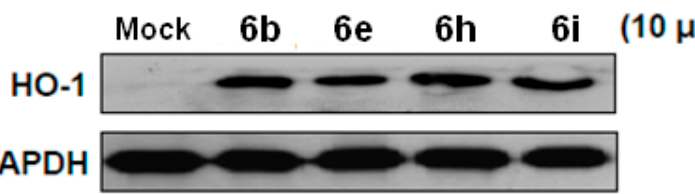
Figure 5. Compounds induced HO-1 protein expression in Ava-5 cells. Compound 6b , 6e , 6h and 6i induced HO-1 protein expression. Ava-5 cells were treated with compounds at 10 µ M for 3 days. The cell lysate was subjected to western blotting with anti-HO-1 and anti-GAPDH antibodies.